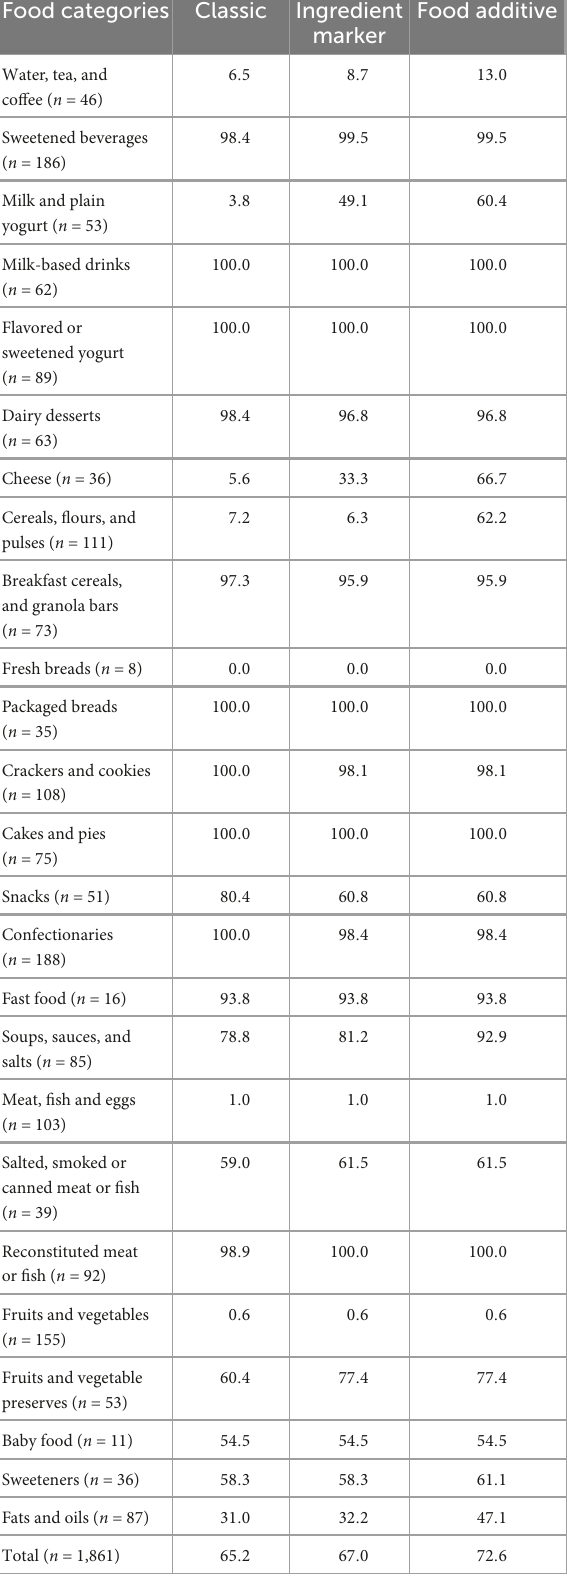
TABLE 3 Proportion (%) of UPF in food and beverages using three methods to identify them, according to food categories ( n =